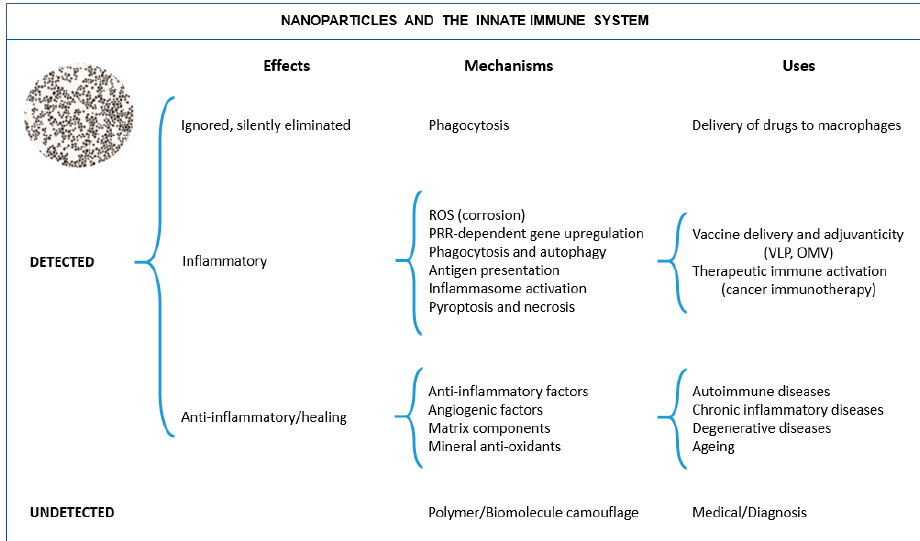
Figure 2. NP-immune system interactions. NPs can be undetected or detected by cells of the immune system, depending on different parameters such as their size, surface charge, and hydrophobicity/hydrophilicity of the surface coating. If detected, NPs can be either tolerated (either ignored or eliminated in a silent fashion, i.e., without inducing an inflammatory reaction) or generate an inflammatory response allowing for resolution of inflammation and tissue regeneration or an anti-inflammatory. With a proper NP design, these responses can be harnessed for developing different immunomodulating activities for medical exploitation (e.g., self-adjuvanted vaccines based on virus-like particles (VLPs), or outer membrane vesicles (OMVs), etc.).